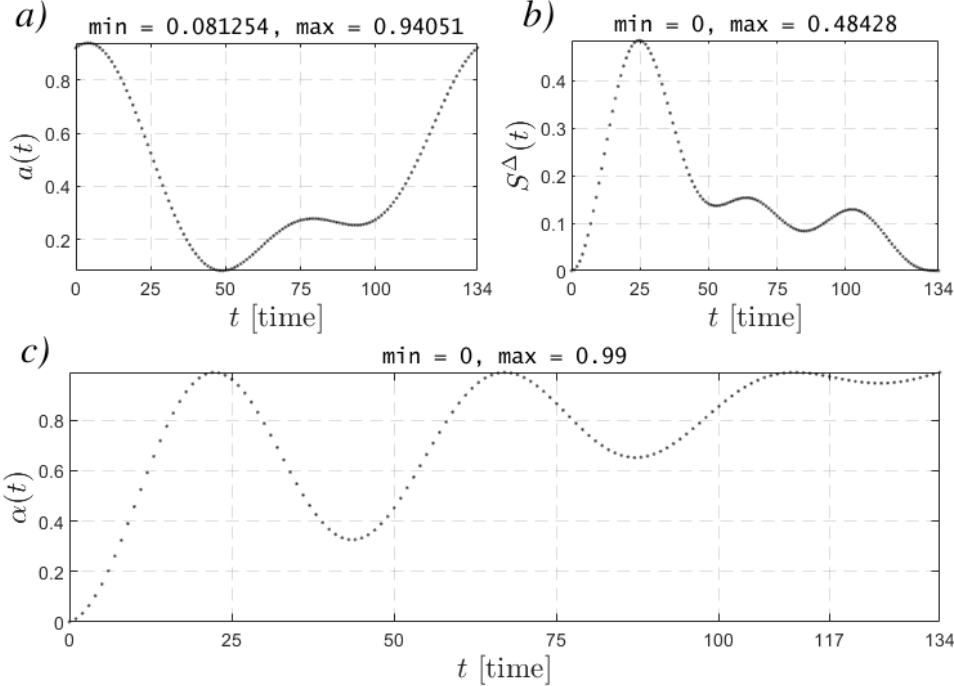
Figure 10. Changing model parameters from time to time for Example